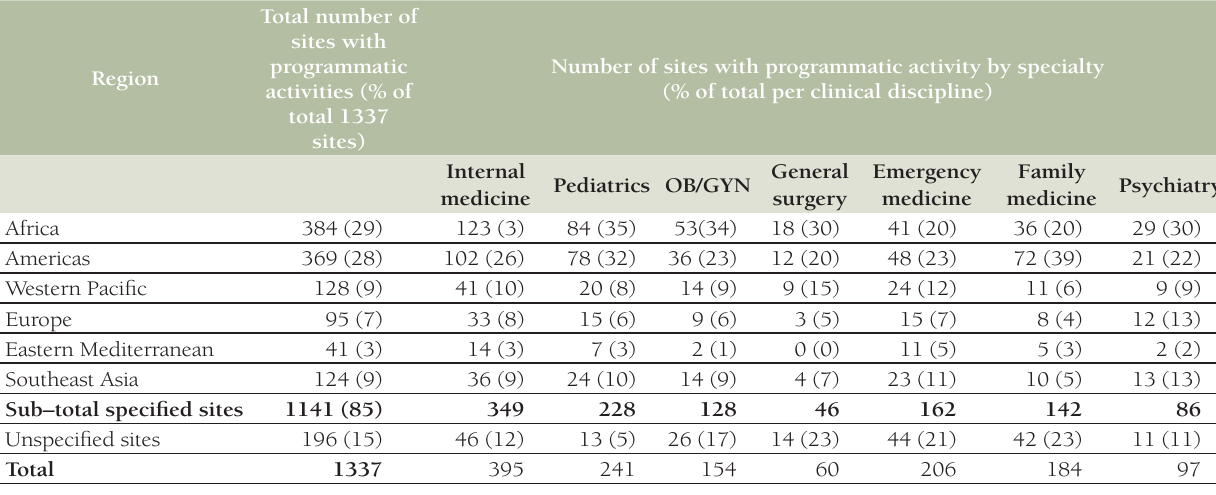
Table 2. Programmatic activity by World Health Organization (WHO) region and clinical specialty*